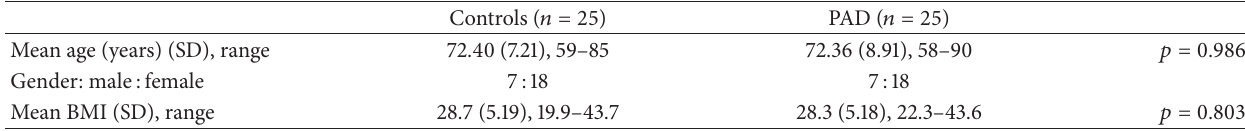
Table 1: Characteristics of the sample